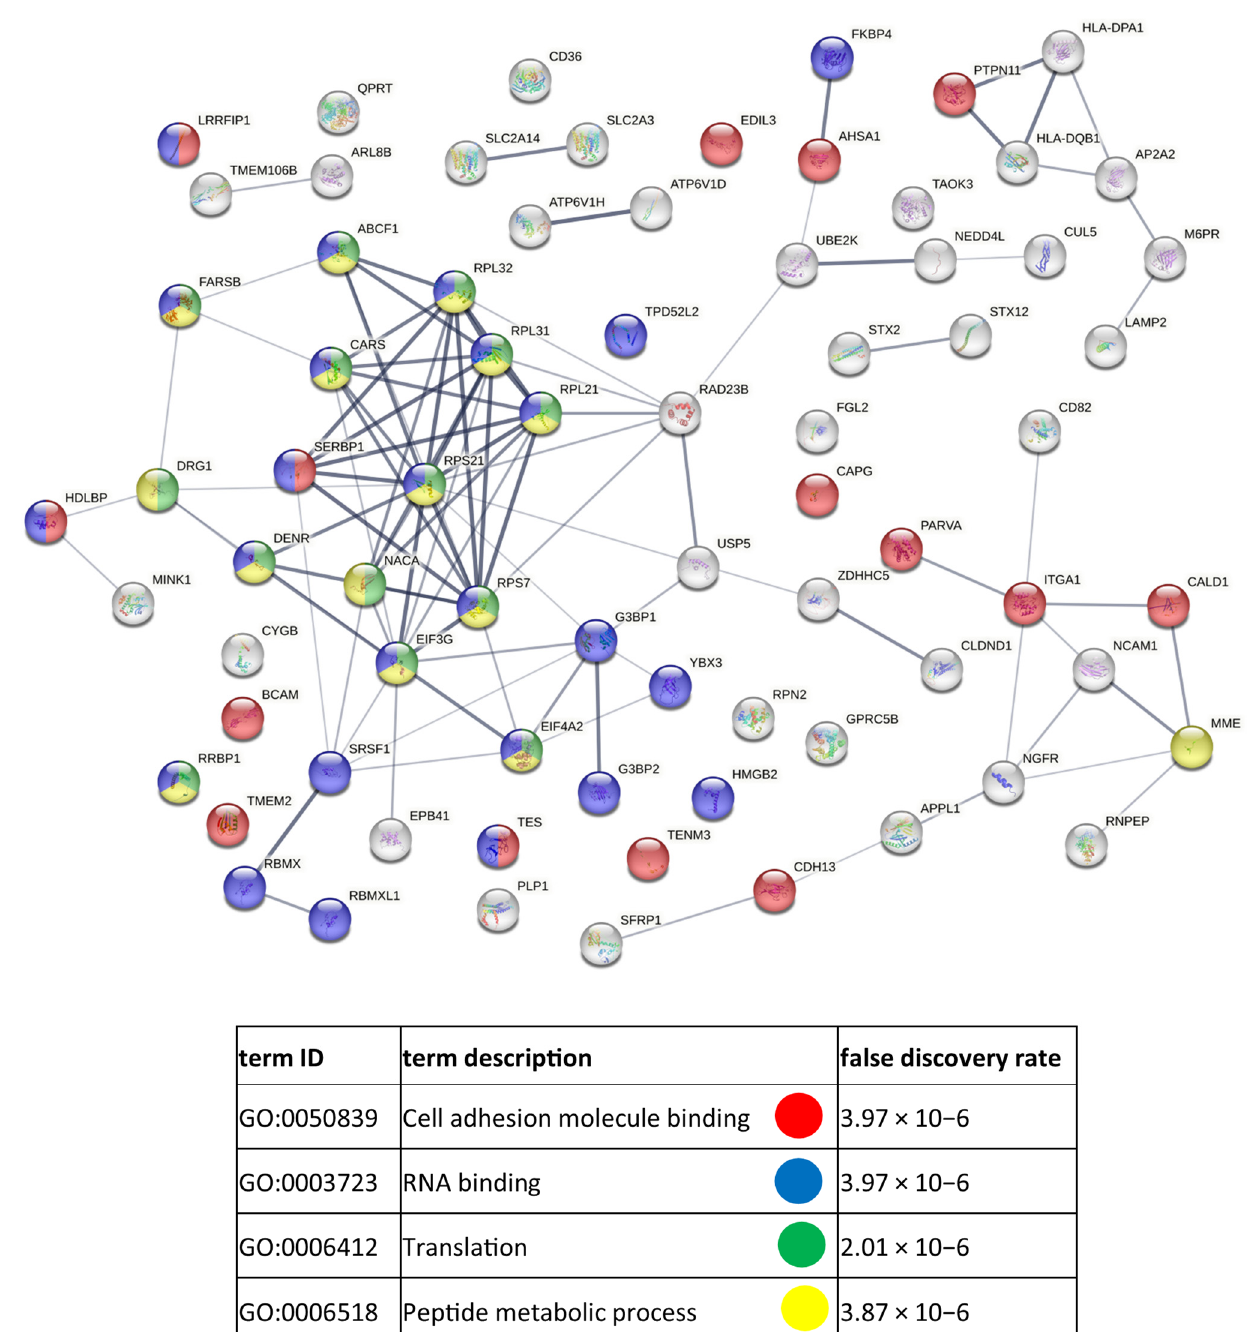
Figure A6. Diagram of functional protein association networks prepared with the use of STRING v. 11.0 software for proteins identified in WM115-derived exosomes but not found in any replicates of WM266-4-derived exosomes. The selected, strongly represented pathways are presented as an interactome. A complete analysis is presented in Supplementary Data S3.